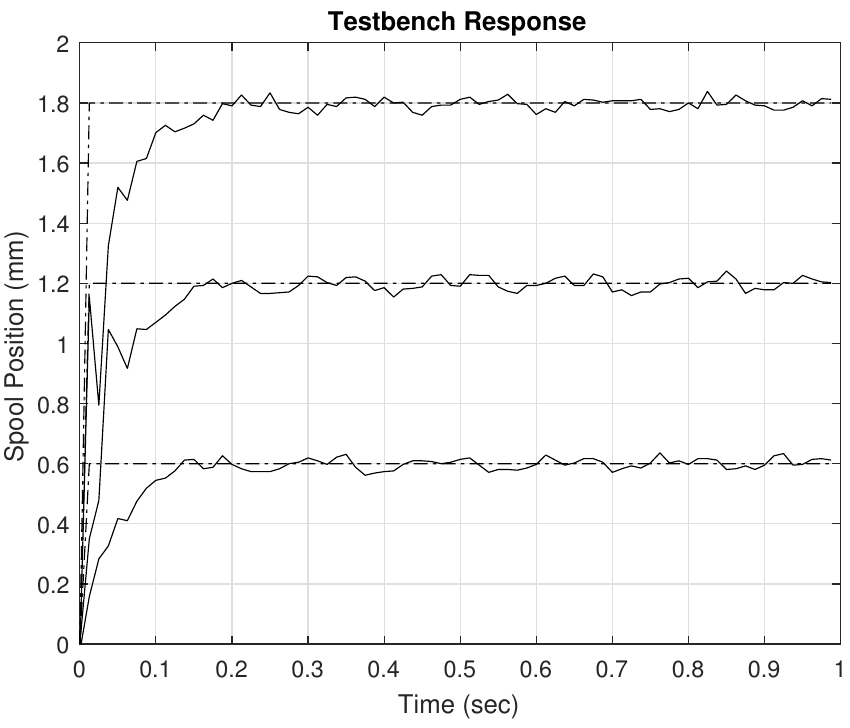
Figure 17. Measured spool position with linear variable differential transducer (LVDT).